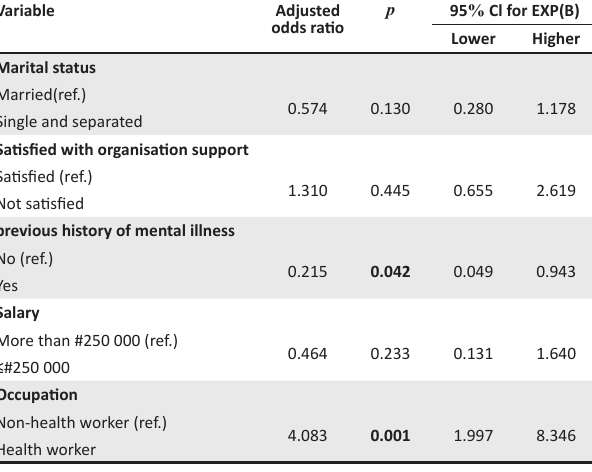
TABLE 5: The socio-demographic variables independently associated with anxiety disorder by logistic regression analysis. Variable